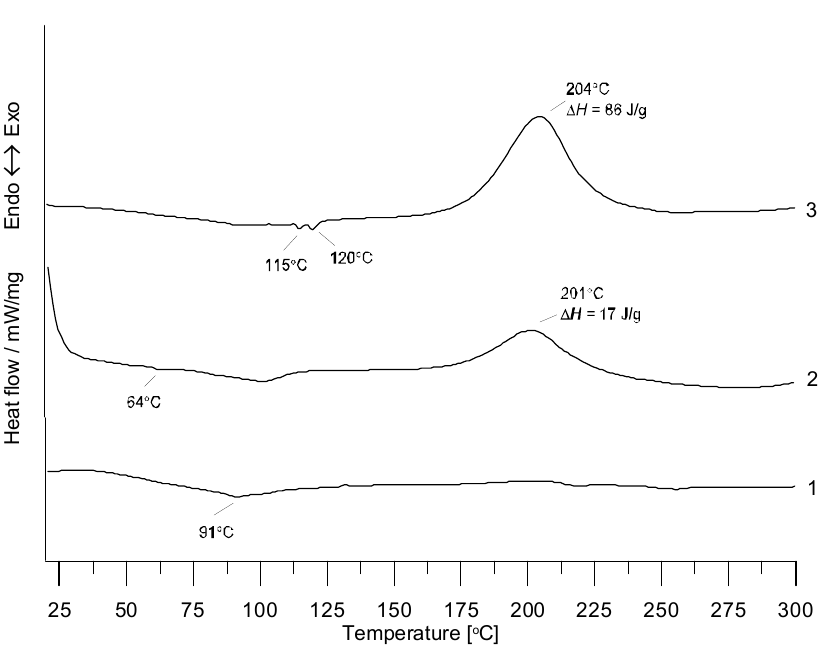
Figure 2. Results of differential scanning calorimetry (DSC) analysis of fresh rubber (1); rubber heated at 190 ◦ C for 2 h to which sulfur was added (2); rubber heated at 190 ◦ C for 2 h to which sulfur and SBS were added (3).